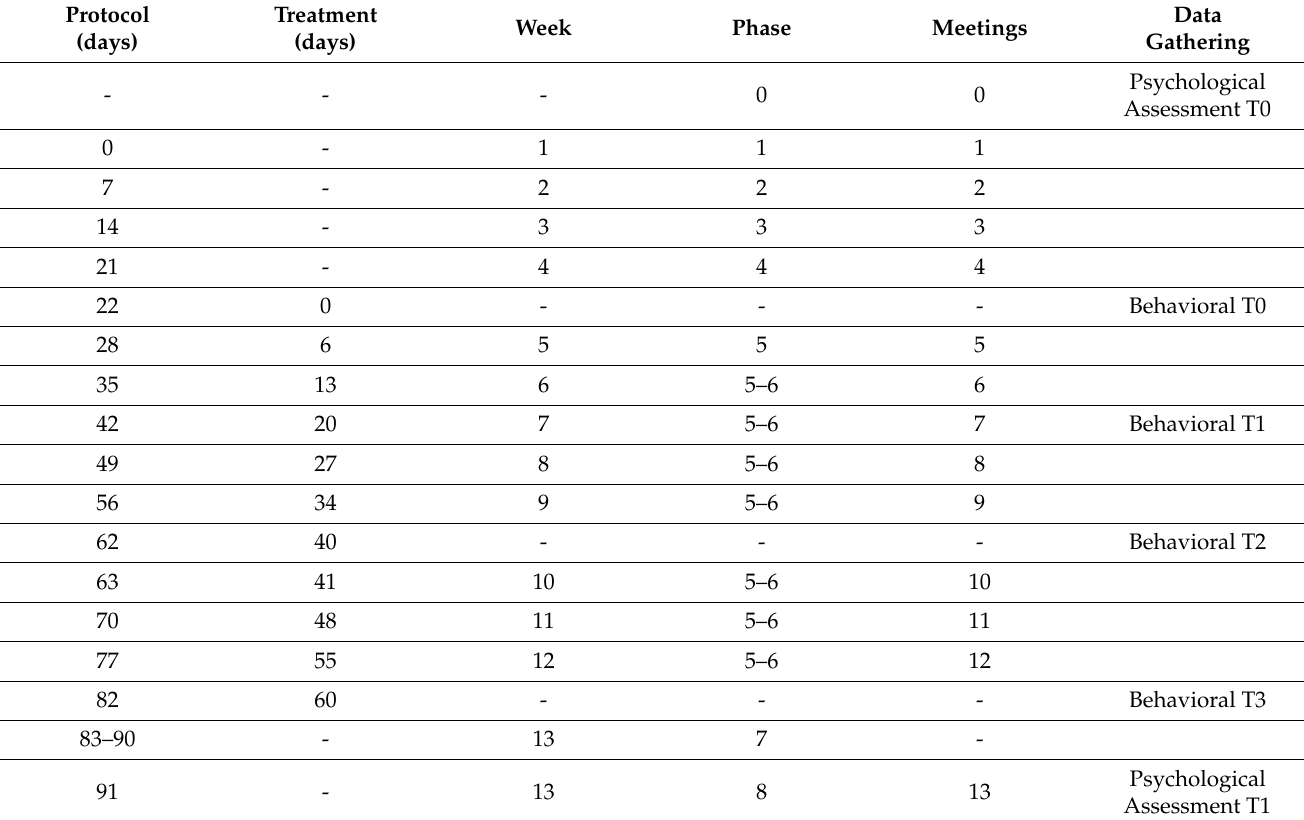
Table 2. Timetable of the protocol and data